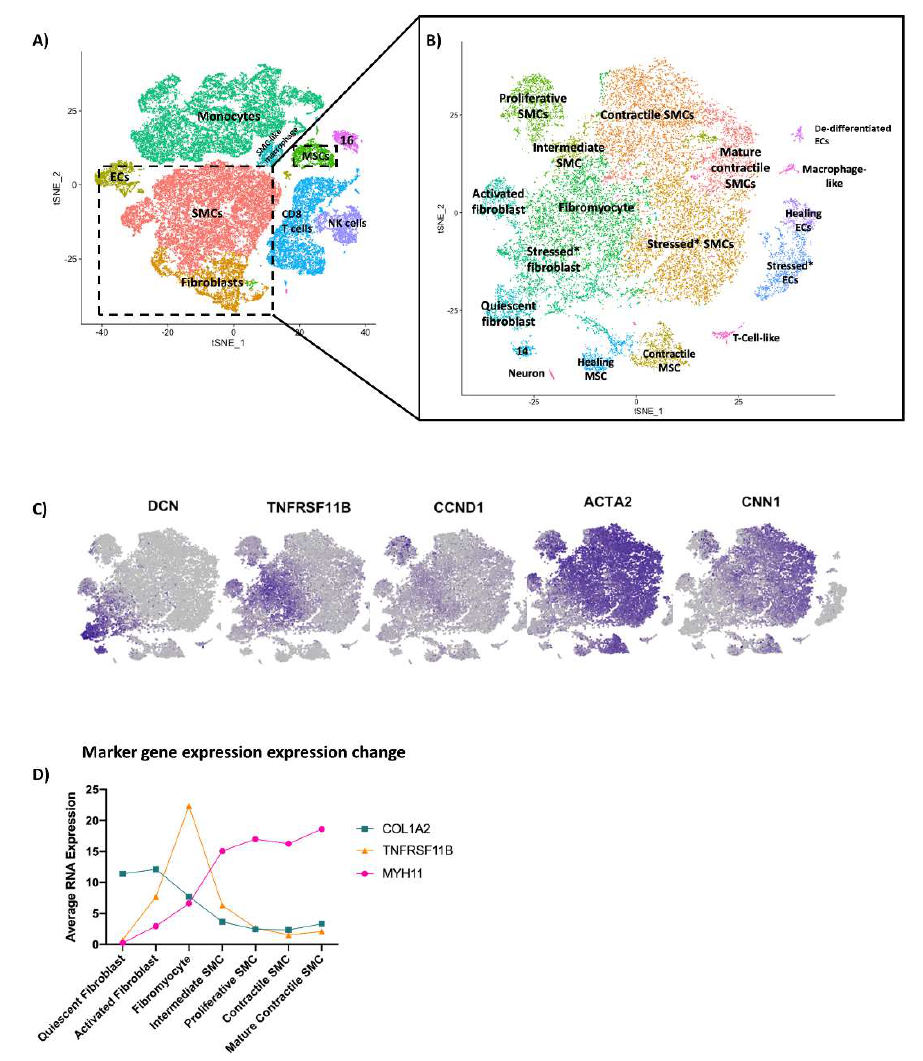
Figure 1. Heterogeneity of non-immune cells in the aortic wall in combined samples of 4 controls and 3 patients with MFS. ( A ) General immune and non-immune cell types in the aortic wall. Cell cluster proportion represents the number of cells after digestion and processing and likely does not represent the true cell proportion in the aortic wall. ( B ) Non-immune cells were extracted from the data and recombined. ( C ) Visualization of the change in expression of common marker genes across the phenotypic continuum of SMCs and fibroblasts. ( D ) Change in expression of MYH11 (contractile marker), COL1A2 (ECM marker), and TNFSRF11B (fibromyocyte marker) throughout the phenotypic continuum in SMCs and fibroblasts.